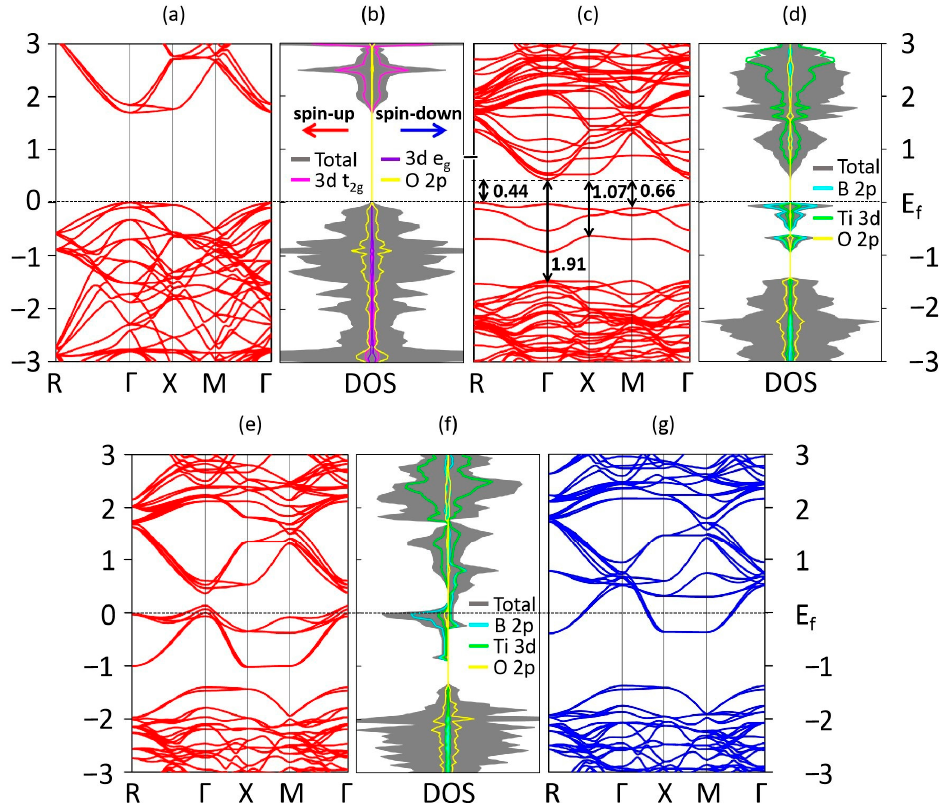
Figure 5. Calculated ( a ) band structure (spin-up channel), ( b ) total density of states (DOS) and partial density of states (PDOS) for the Ti 3d t 2g , Ti 3d e g , and O 2p orbitals of un-doped SrTiO 3 . ( c ) Band structure (spin-up channel), ( d ) DOS and PDOS for the B 2p, Ti 3d and O 2p orbitals of the (0,1) structure. ( e ) Band structure (spin-up channel), ( f ) DOS and PDOS for the B 2p, Ti 3d and O 2p orbitals and ( g ) band structure (spin-down channel) of the (0,7) structure. The Fermi level is marked by a dashed line. PDOS plots are all amplified five times for